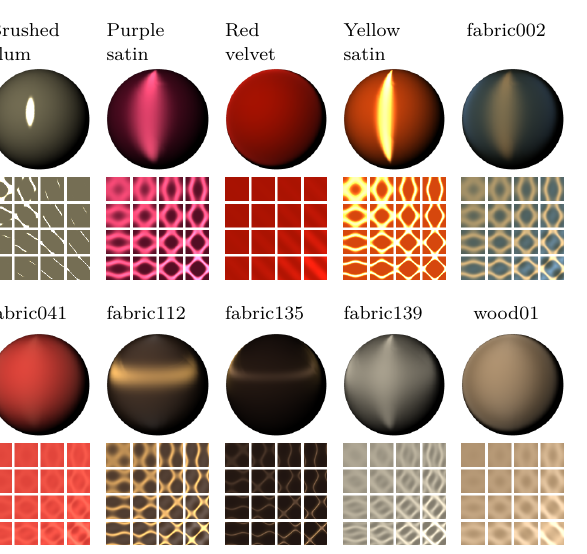
Ten test materials represented by the BRDF model in Ref. [20], rendered on spheres, with visualizations of their